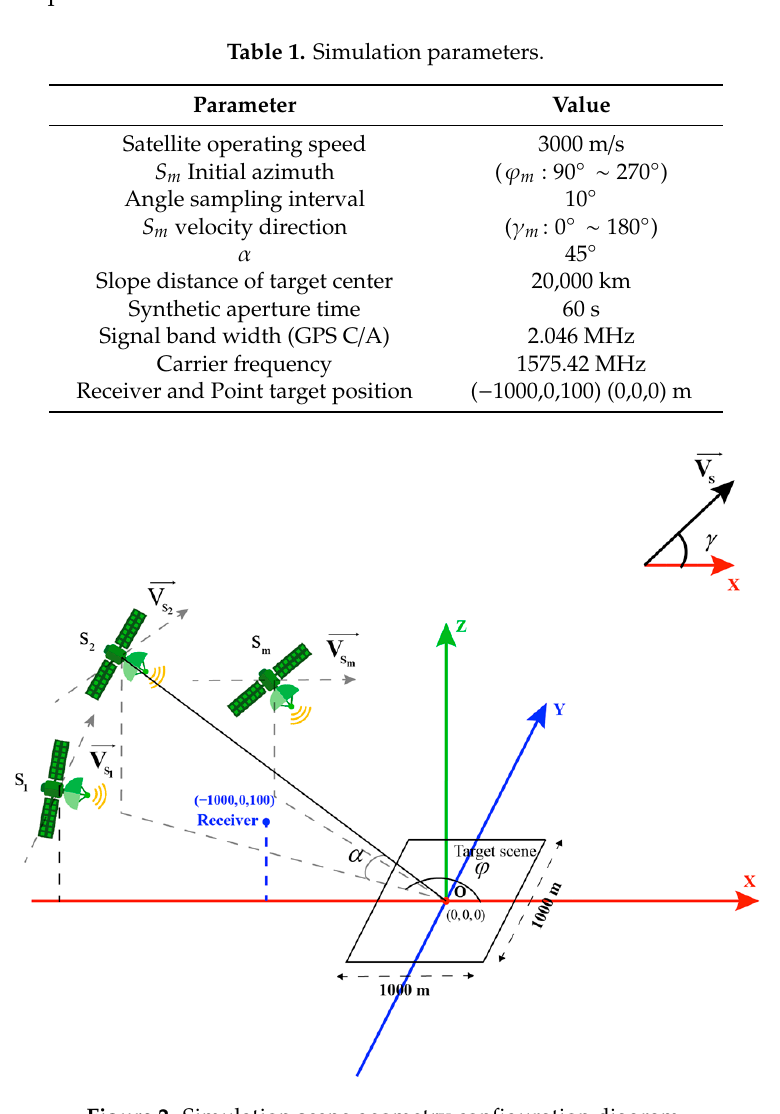
Figure 2. Simulation scene geometry configuration diagram. Table 1. Simulation parameters.